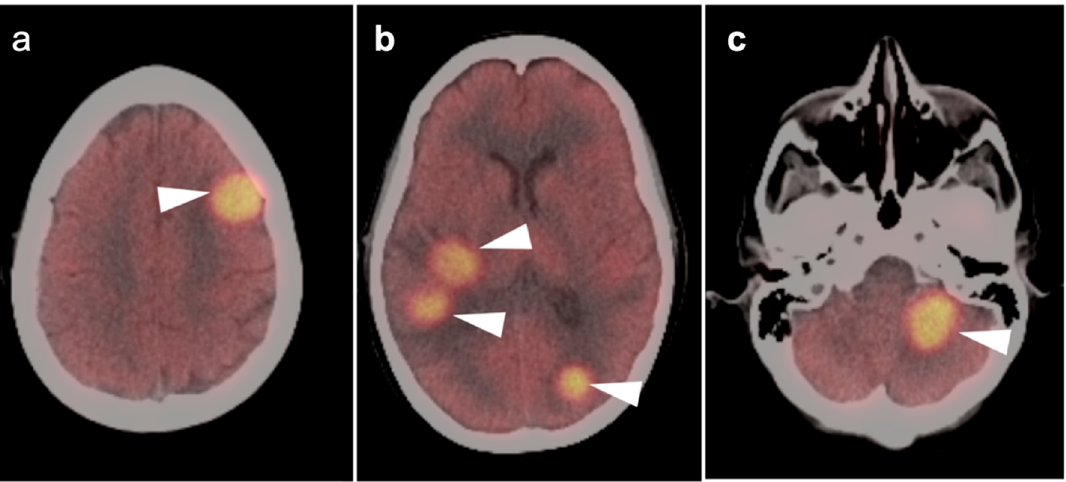
Figure 44. Hypermetabolic brain metastases (breast cancer). ( a – c ) There are multiple intensely hypermetabolic nodules in the brain on axial fused FDG PET-CT images (white arrowheads). These were breast cancer metastases.